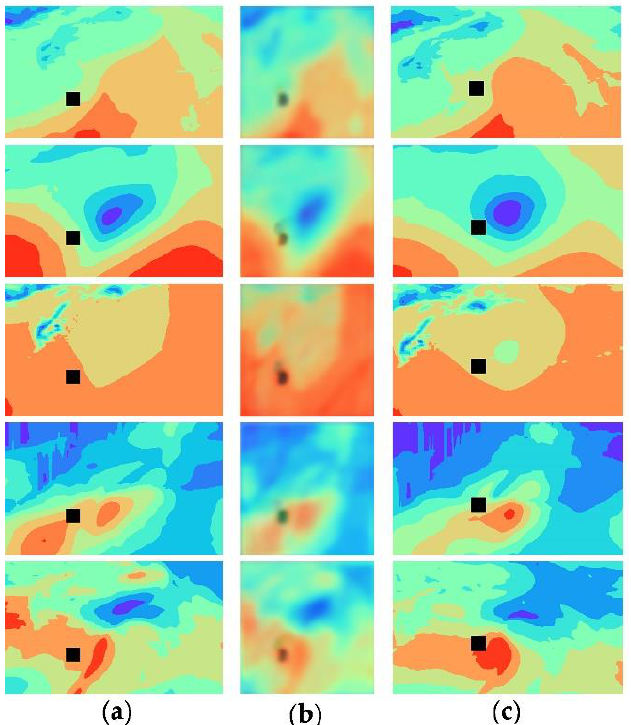
Figure 8. Diagrams comparing images at previous moments in time, depicting predicted images and current original images of Typhoon HAGIBIS. ( a ) Earlier images of Typhoon HAGIBIS. ( b ) Predicted images of Typhoon HAGIBIS. ( c ) Current original images of Typhoon HAGIBIS.